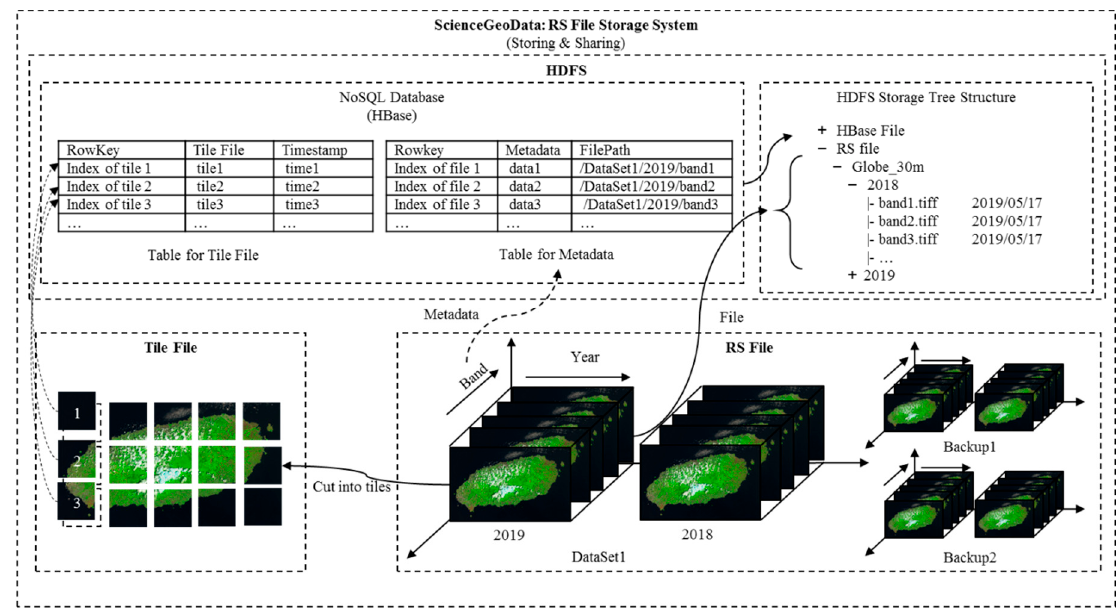
Figure 2. Remote sensing data system with a Hadoop Distributed File System (HDFS) and HBase.